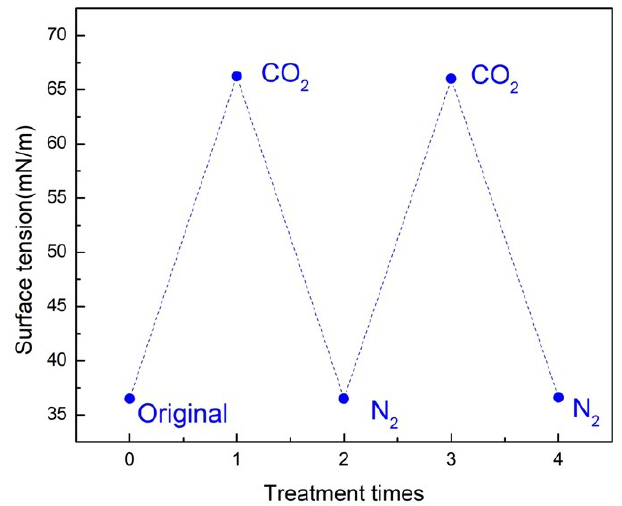
Figure 4. Changes in surface tension of an aqueous solution of copolymer 1 (0.2 wt%) as a function of treatment time under alternating two–cycle CO 2 /N 2 bubbling.